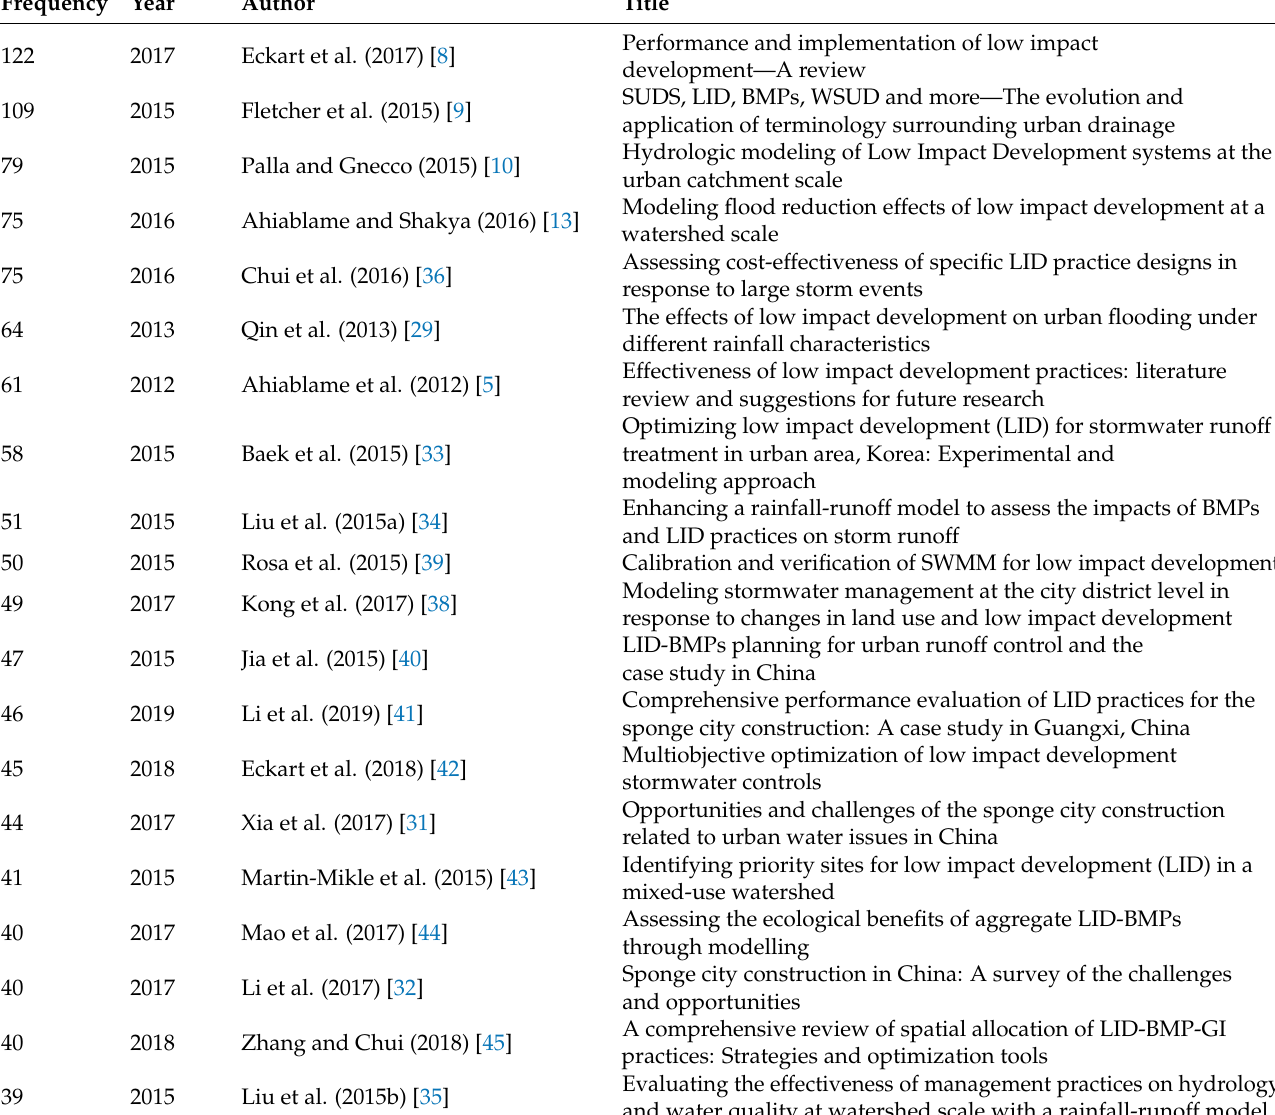
Table 7. The key publications from co-citation references clustering according to the